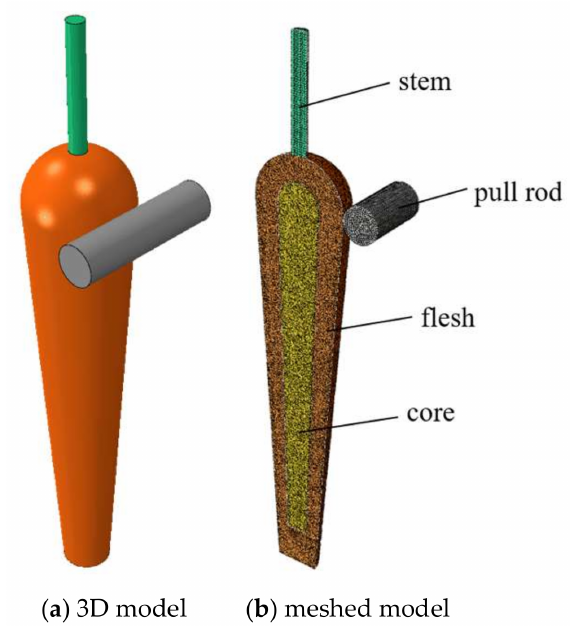
Figure 6. Impact simulation using